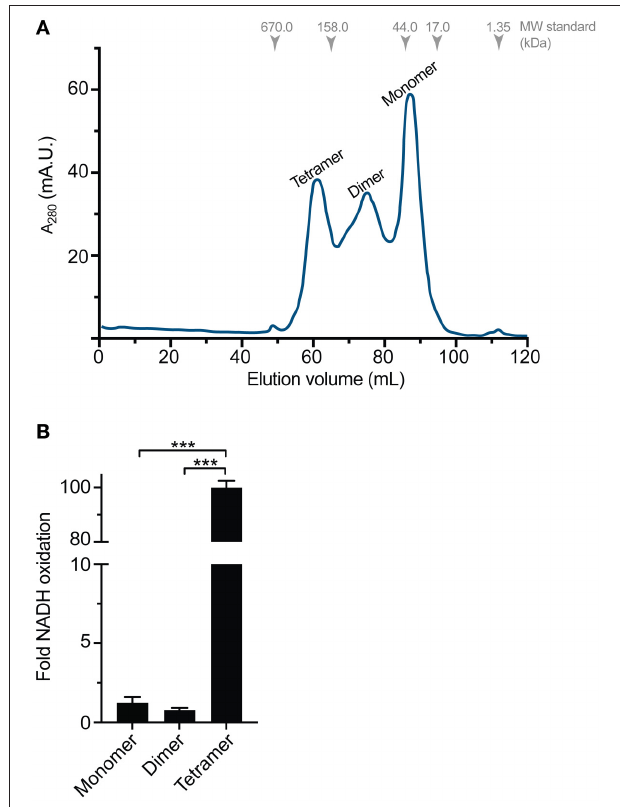
FIGURE 3 | Distinct oligomeric states of recombinantly expressed TeMVK. (A) Gel filtration chromatogram (monitored at λ = 280nm) of TeMVK expressed in autoinduction medium ZYM5052 and purified using a Superdex200 16/600 column in buffer containing 30mM glycine, pH 9.0, and 150mM NaCl. The three peaks correspond to distinct oligomers: tetramer, dimer, and monomer. (B) Fold increase of NADH oxidation using recombinantly expressed TeMVK. Bars indicate the mean ± SD from three independent experiments with three technical replicates (*** P < 0.001, unpaired t -test).